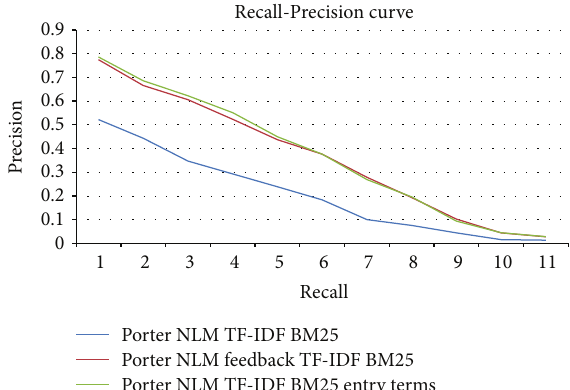
Figure 2: Recall-Precision curve obtained with the query expansion methods using the MeSH, Abstract, and Title